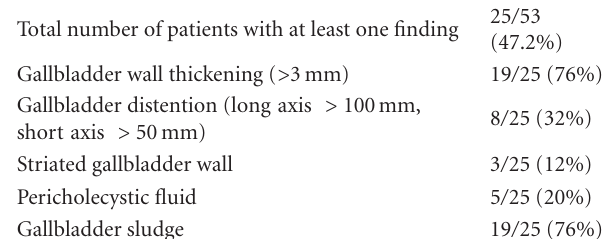
Table 2: Ultrasound results in the 25 patients who exhibited at least one